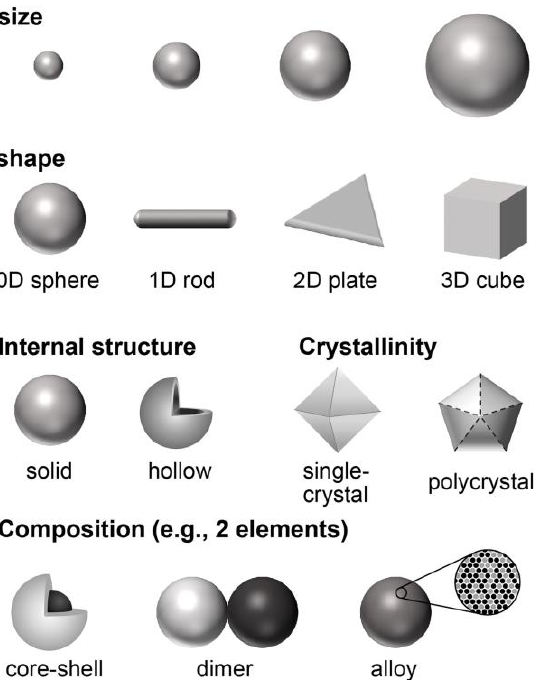
Figure 2. Schematics showing the physicochemical parameters of NM NPs that can be controlled during a synthesis. during a